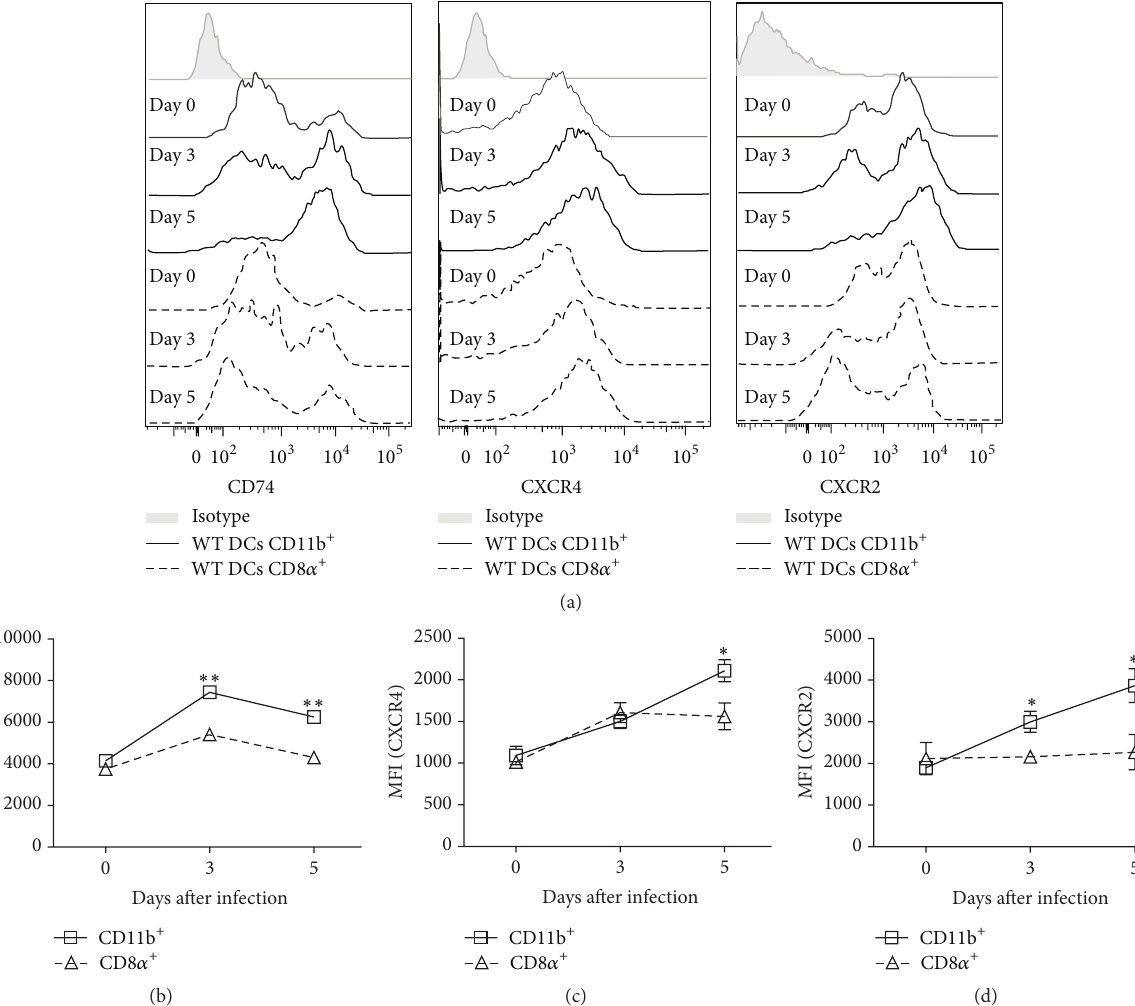
Figure 5: MIF receptors CXCR2, CXCR4, and CD74 are highly expressed on conventional CD11b + DCs but not CD8 𝛼 + DCs. Analysis of CXCR2, CXCR4, and CD74 expression on DCs from T. gondii -infected WT mice. (a) Representative histograms of CXCR2, CXCR4, and CD74 MFI in CD11b + (solid line) and CD8 𝛼 + (dashed line) DCs at 0, 3, and 5 days after infection. Kinetics of (b) CD74, (c) CXCR4, and (d) CXCR2 MFI in WT CD11b + ( ◻ ) and WT CD8 𝛼 + ( 󳵻 ) DCs during acute T. gondii infection ( 𝑛 = 3 animals at each time point, representative